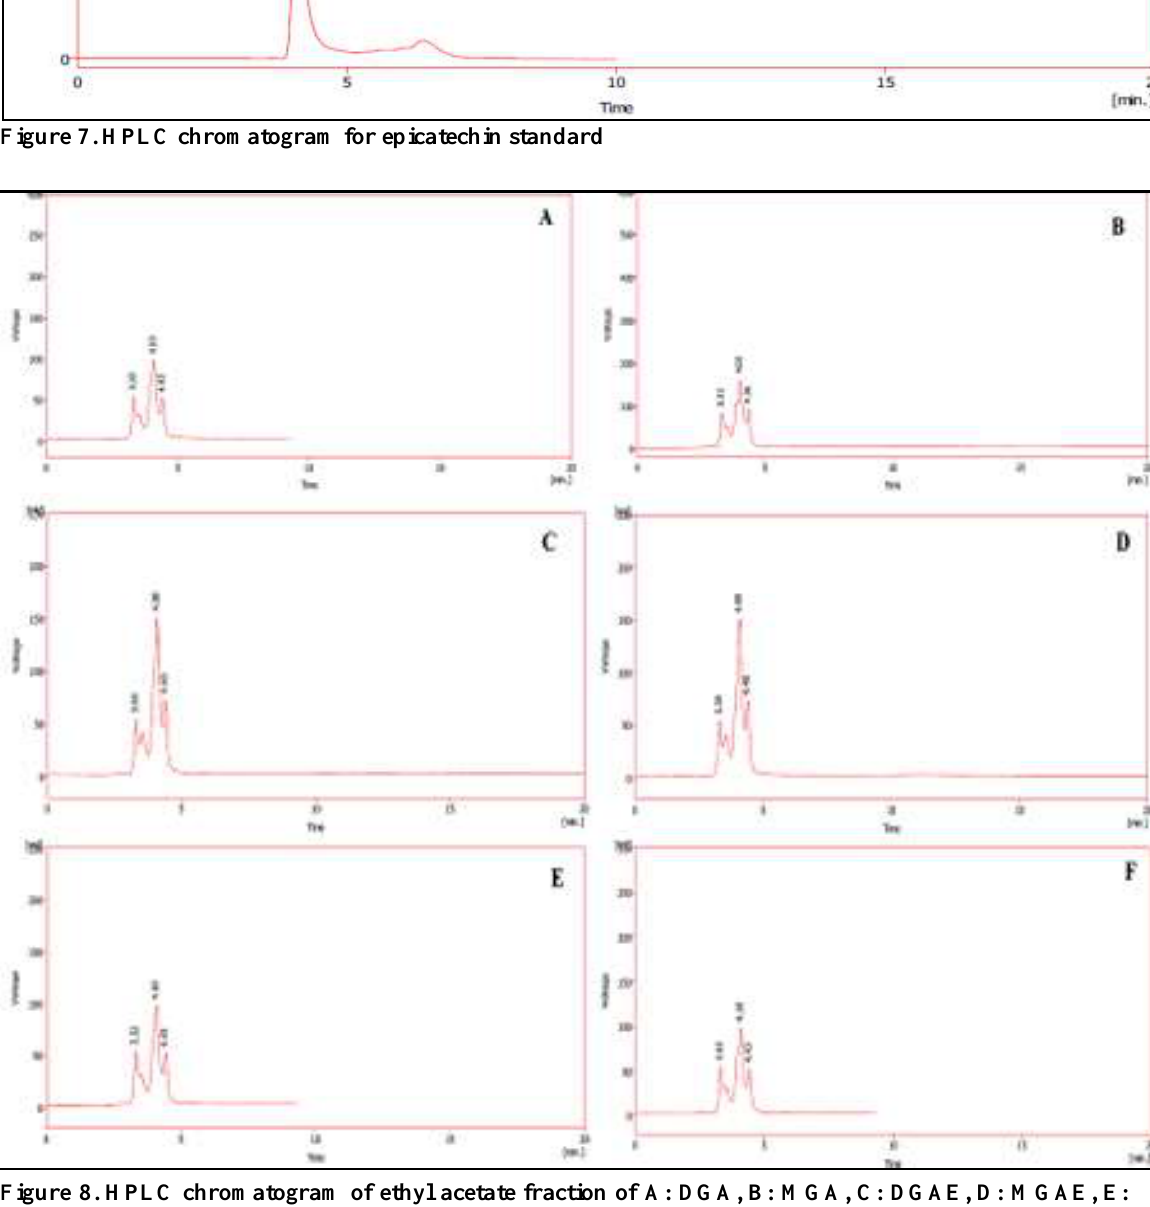
Figure 8. HPLC chromatogram of ethyl acetate fraction of A: DGA, B: MGA, C: DGAE, D: MGAE, E: DGE, F: